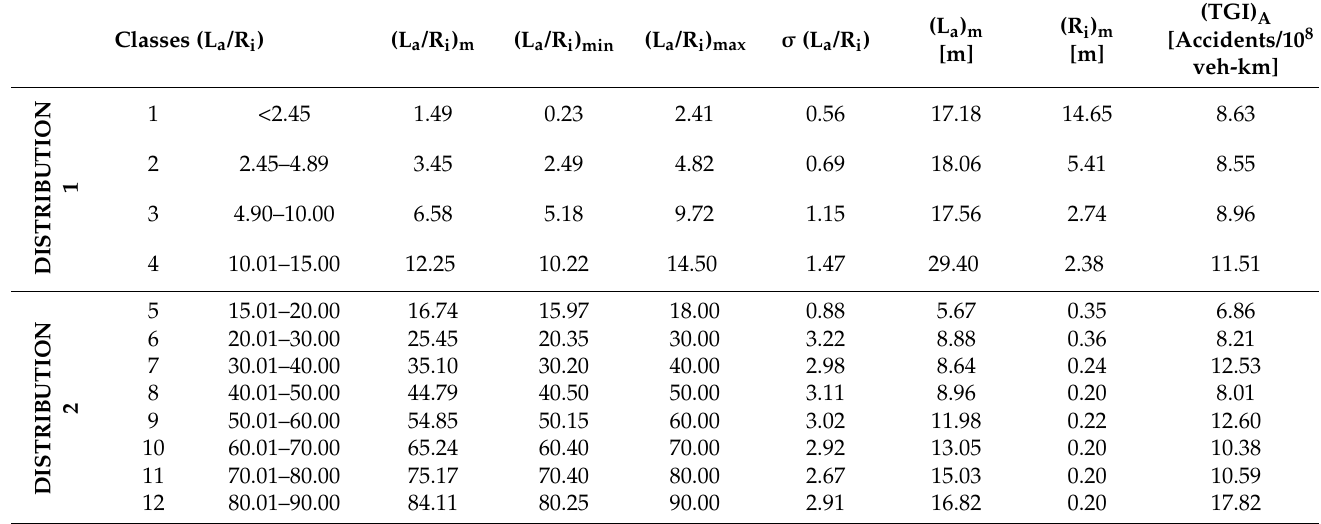
Table 9. Values of L a , R i , L a /R i, and (TGI) A obtained for each